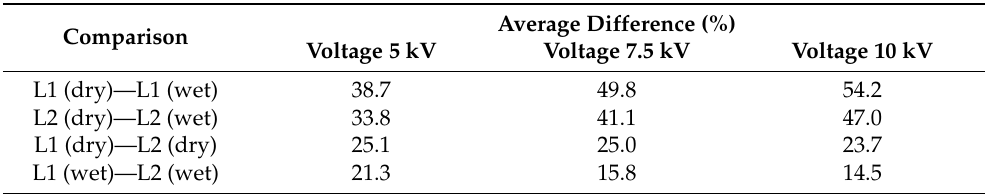
Table 4. The average difference between dielectric loss factors of different pollution levels and different